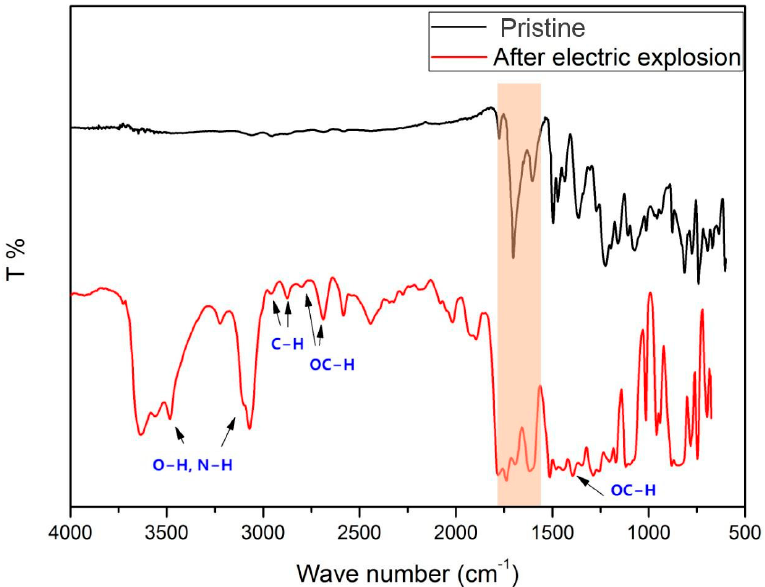
Figure 10. FTIR spectra for pristine polyimide film and sample after the electric explosion test.